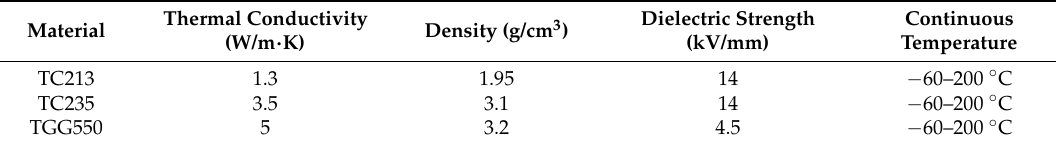
Table 7. The properties of potting material.